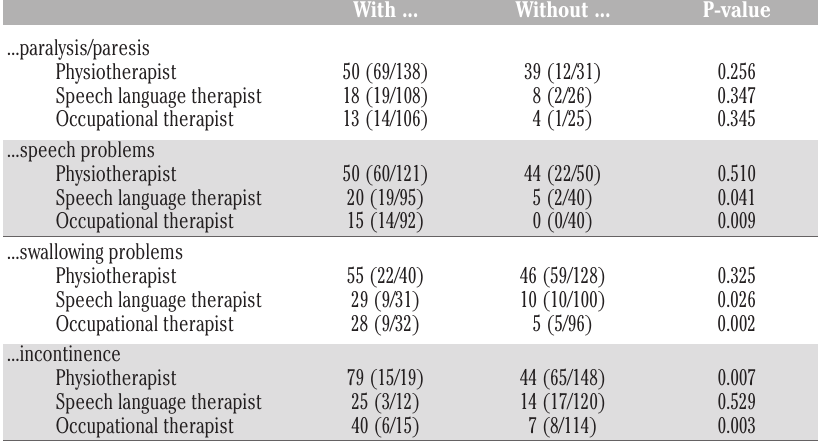
Table 2. Follow-up 6 months after the event and according to the neurological deficit in % (n/N).